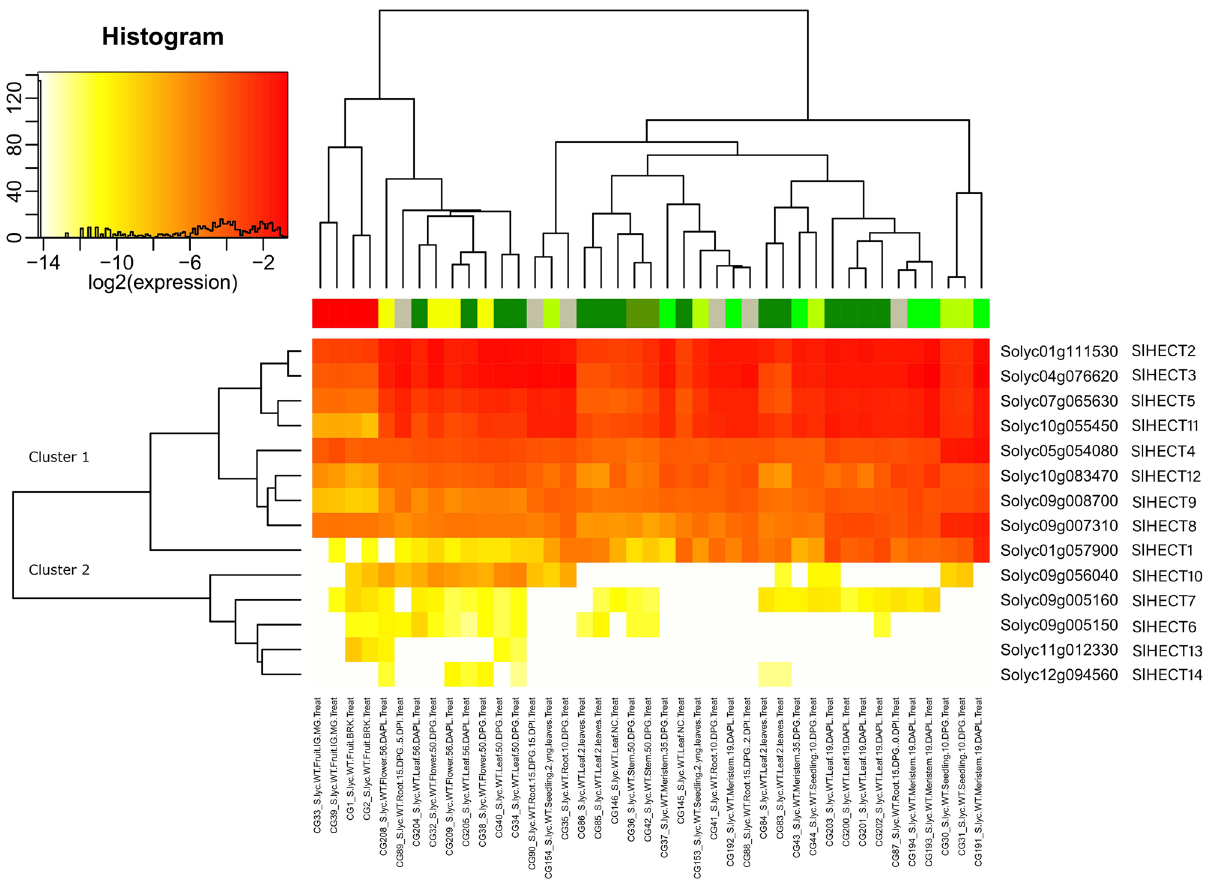
Figure 8. Gene expression levels of fourteen tomato HECT E3 ubiquitin ligase gene family members under abiotic and biotic stress treatments in vegetative and reproductive tissues represented by heat map (Supplementary Table